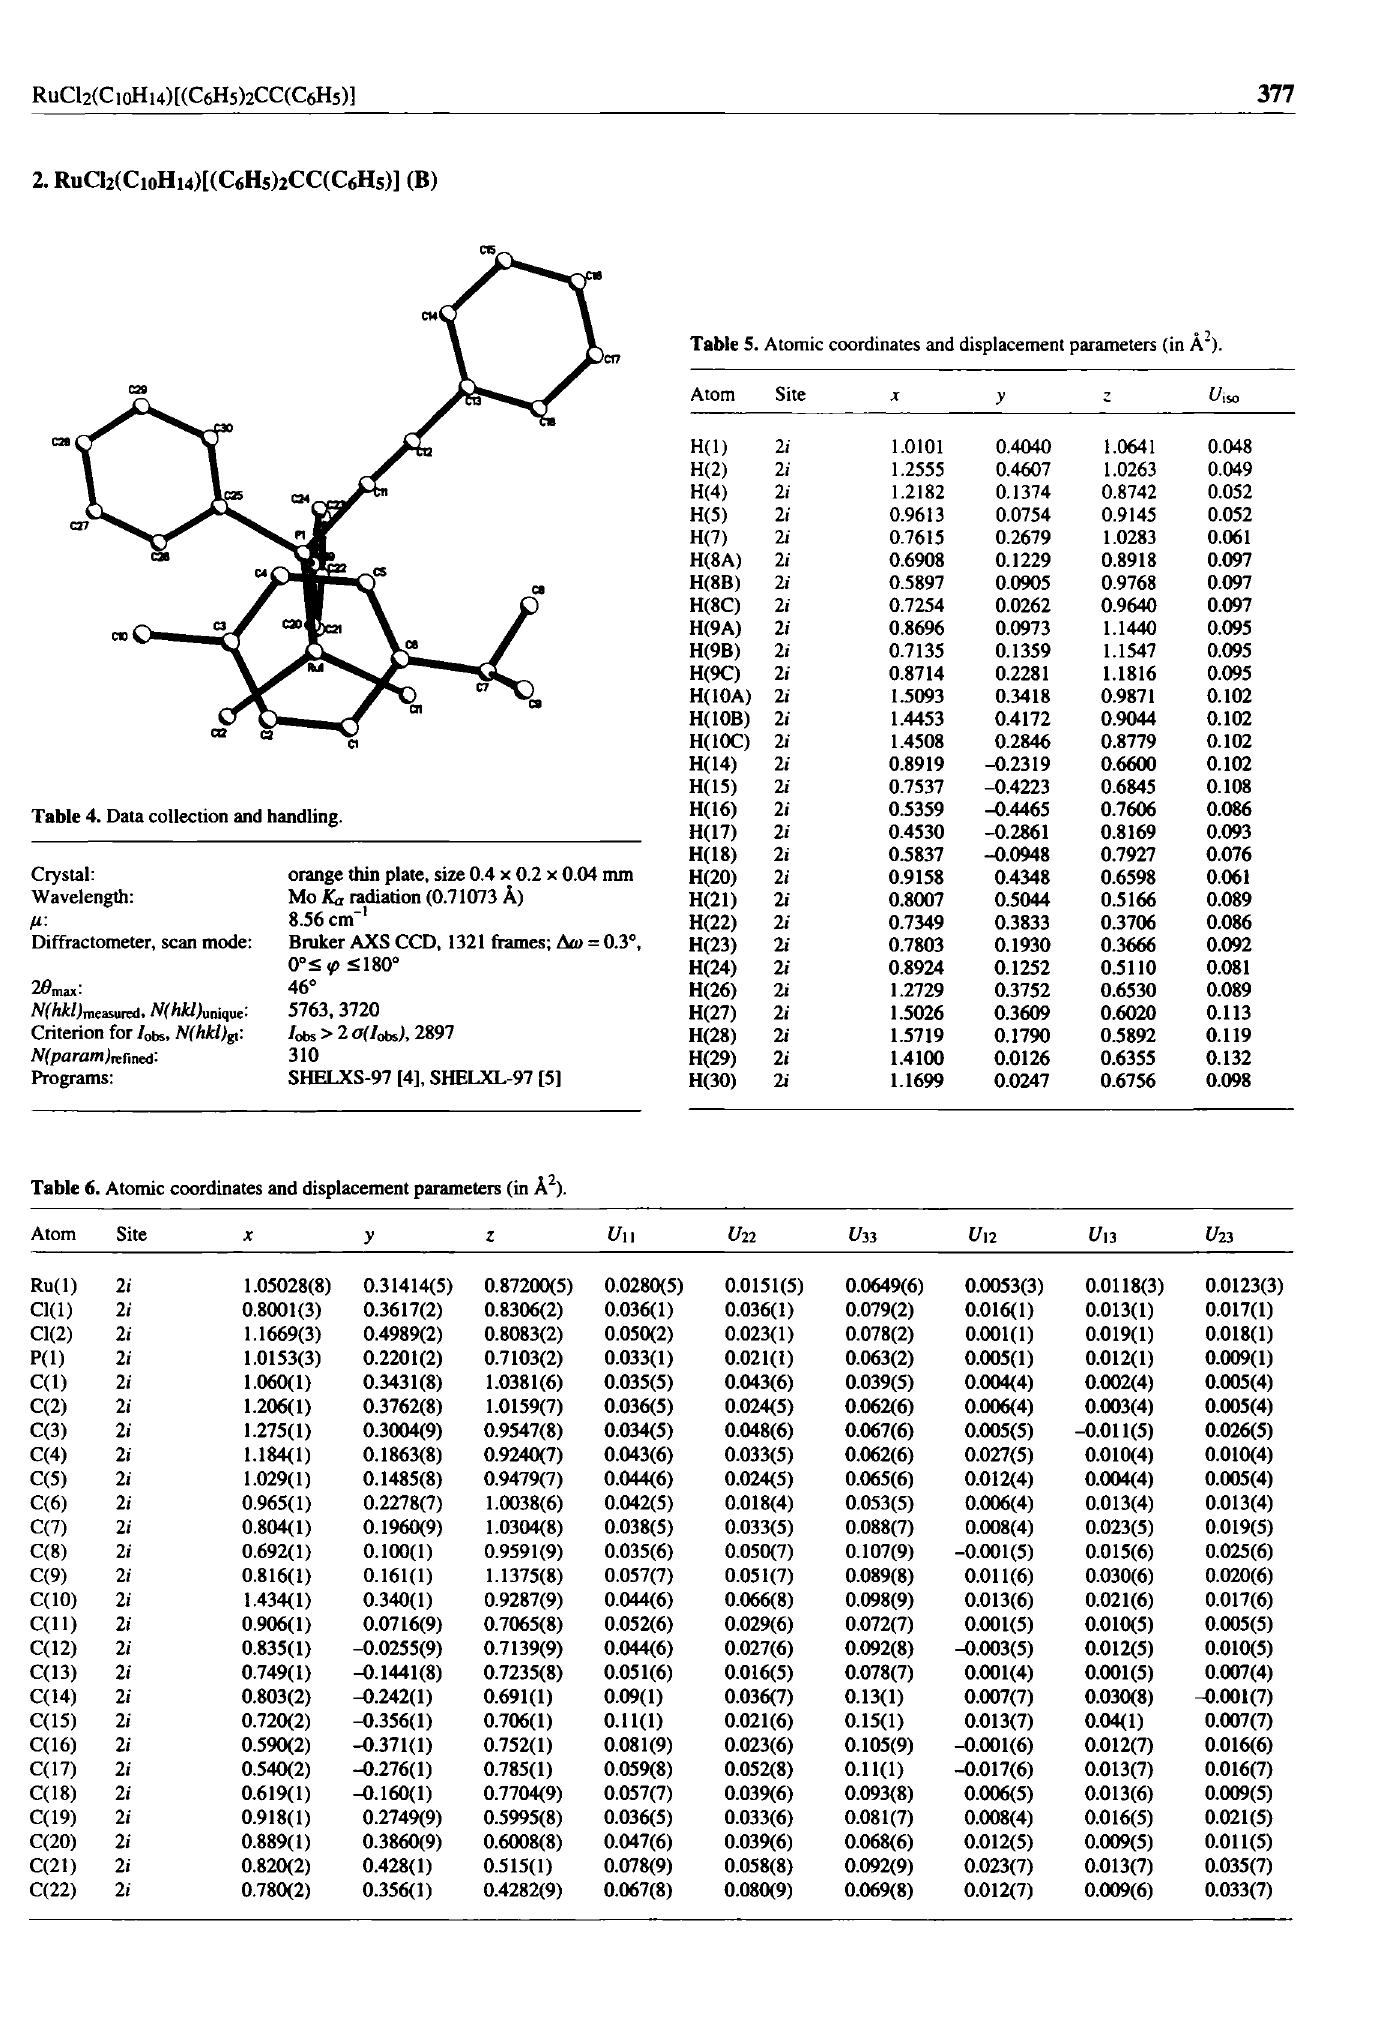
Table 5. Atomic coordinates and displacement parameters (in À").